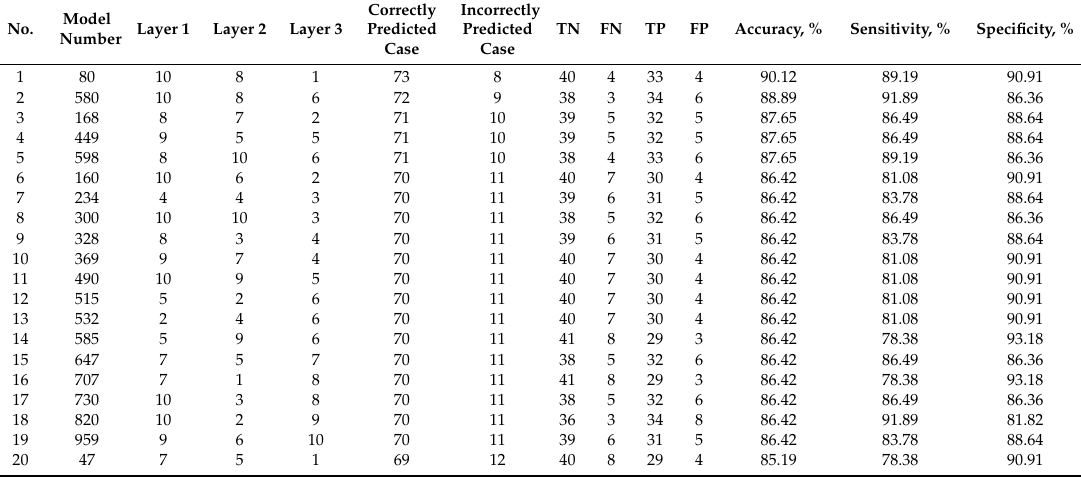
Table 9. Top twenty “Accuracy” results for logistic activation function ANN models.